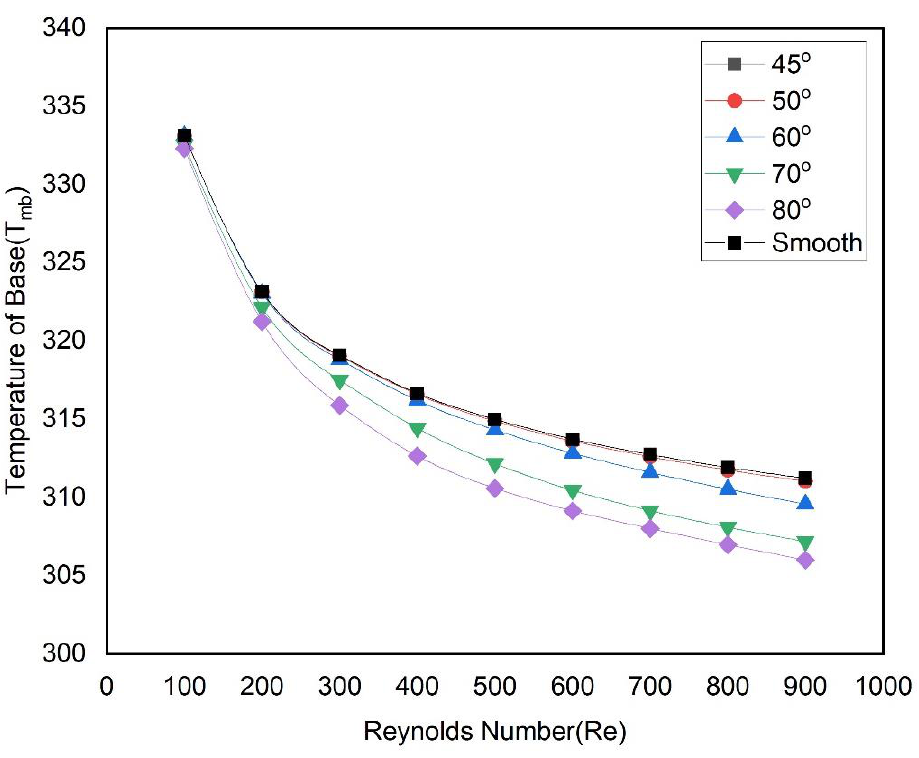
Figure 10. Variation of temperature at the fluid and MCHS interface base wall with Reynolds numbers for different angles.